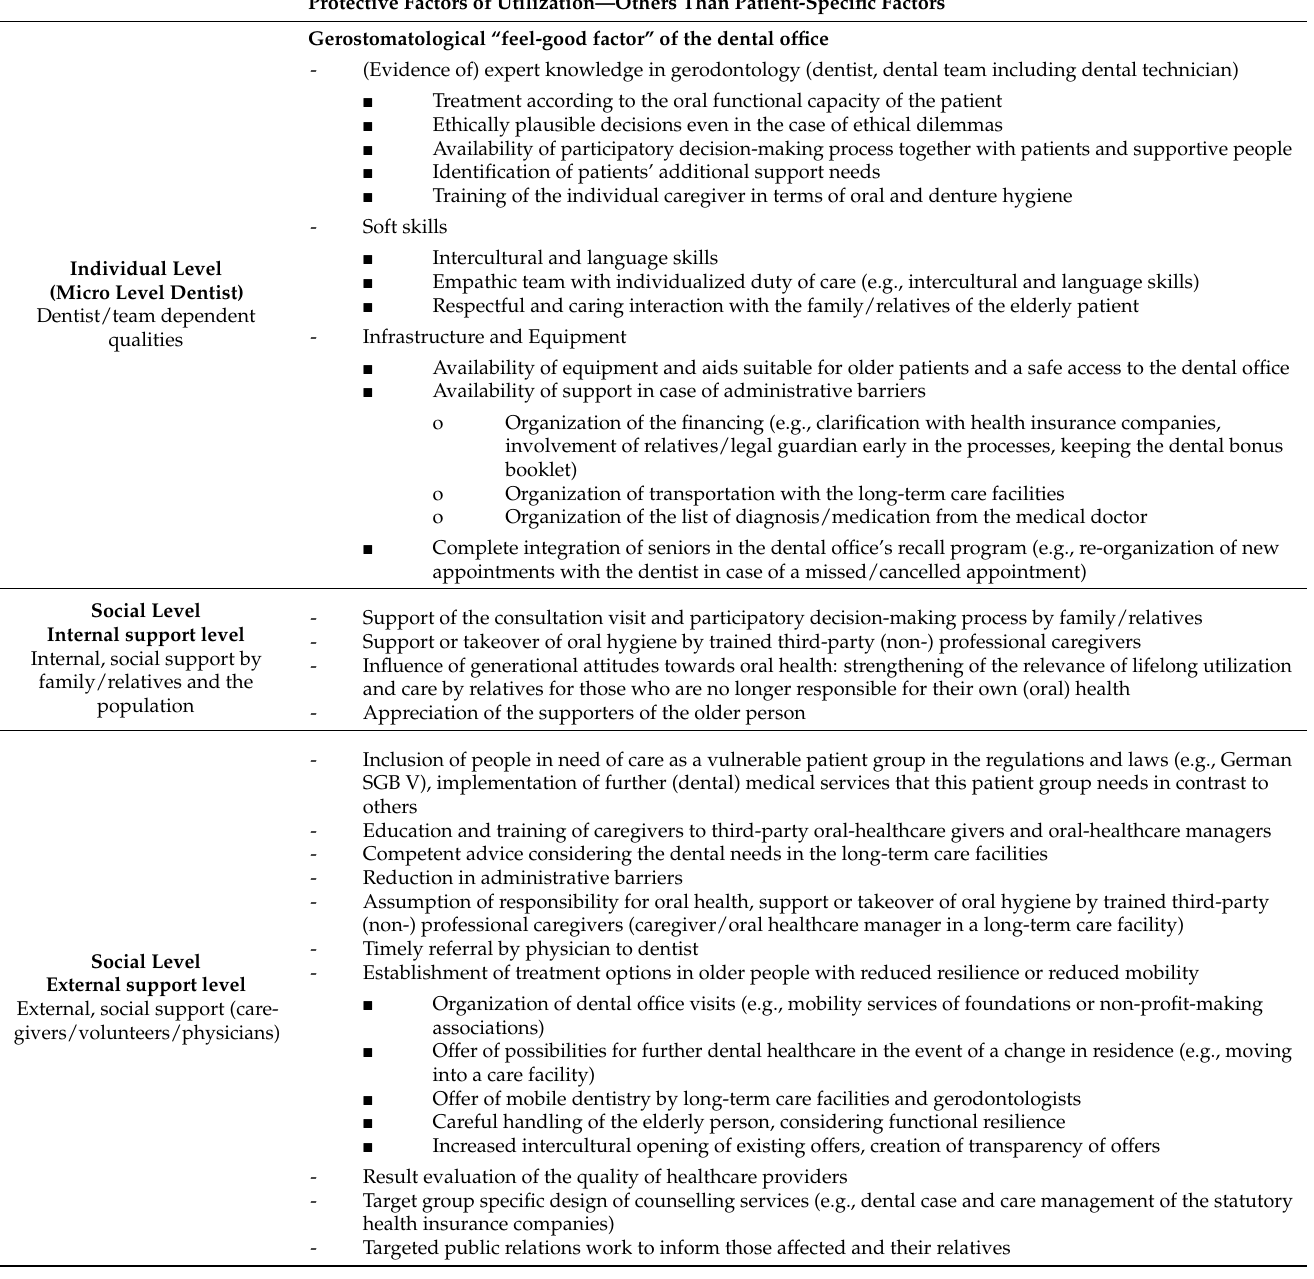
Table 3. Protective factors of utilization—factors that promote oral-health-related resilience and contribute to the improve- ment of control-oriented utilization of dental healthcare (listing and organization with magnitude of importance based on expert